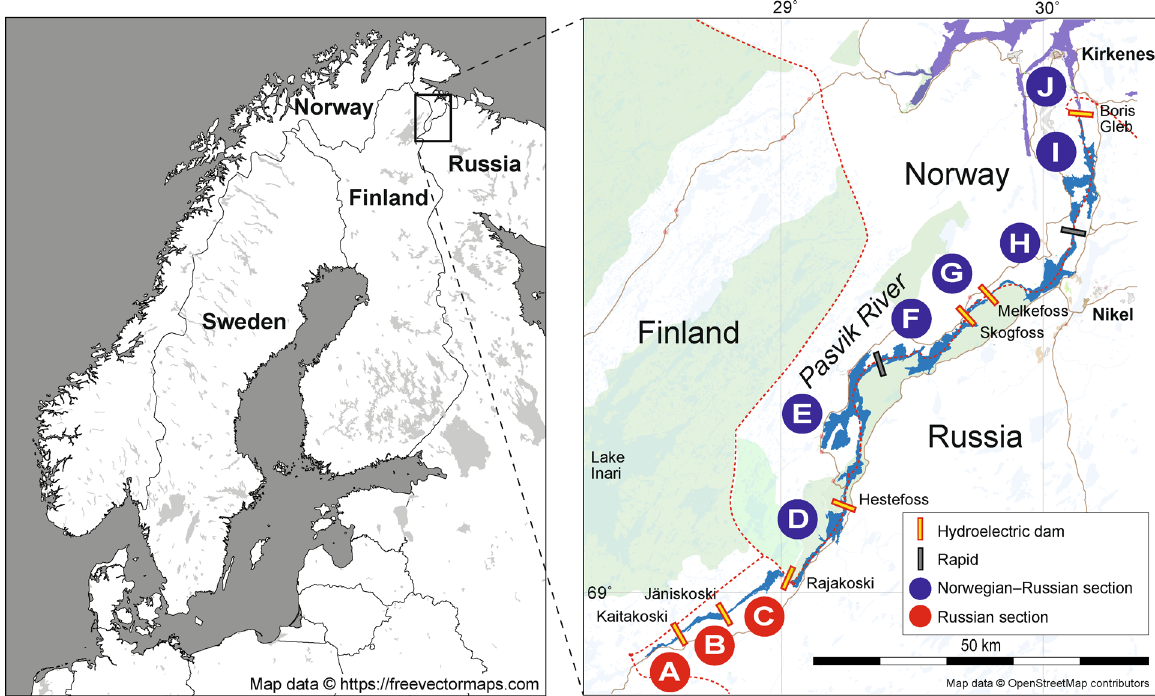
Figure 1. Overview of study area. The different river parts that are separated by hydroelectric dams (orange) are denoted by different letters (A–J). This is a modified map from 4 based on an OpenStreetMap template (https:// www. opens treet map. org/# map=7/ 69. 701/ 24. 053), which is available as open data (https:// www. opens treet map. org/ copyr